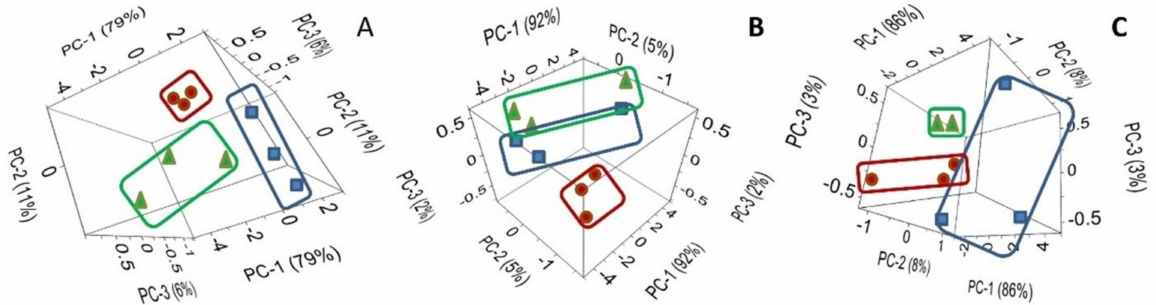
Figure 6. The PCA score graph of the first three PC for ATR-FTIR spectral data of C. arietinum root ( A ), stem ( B ), and leaf ( C ) samples grown in the presence of: (1) Au NPs (blue), (2) CNTs (red), and (3) control group